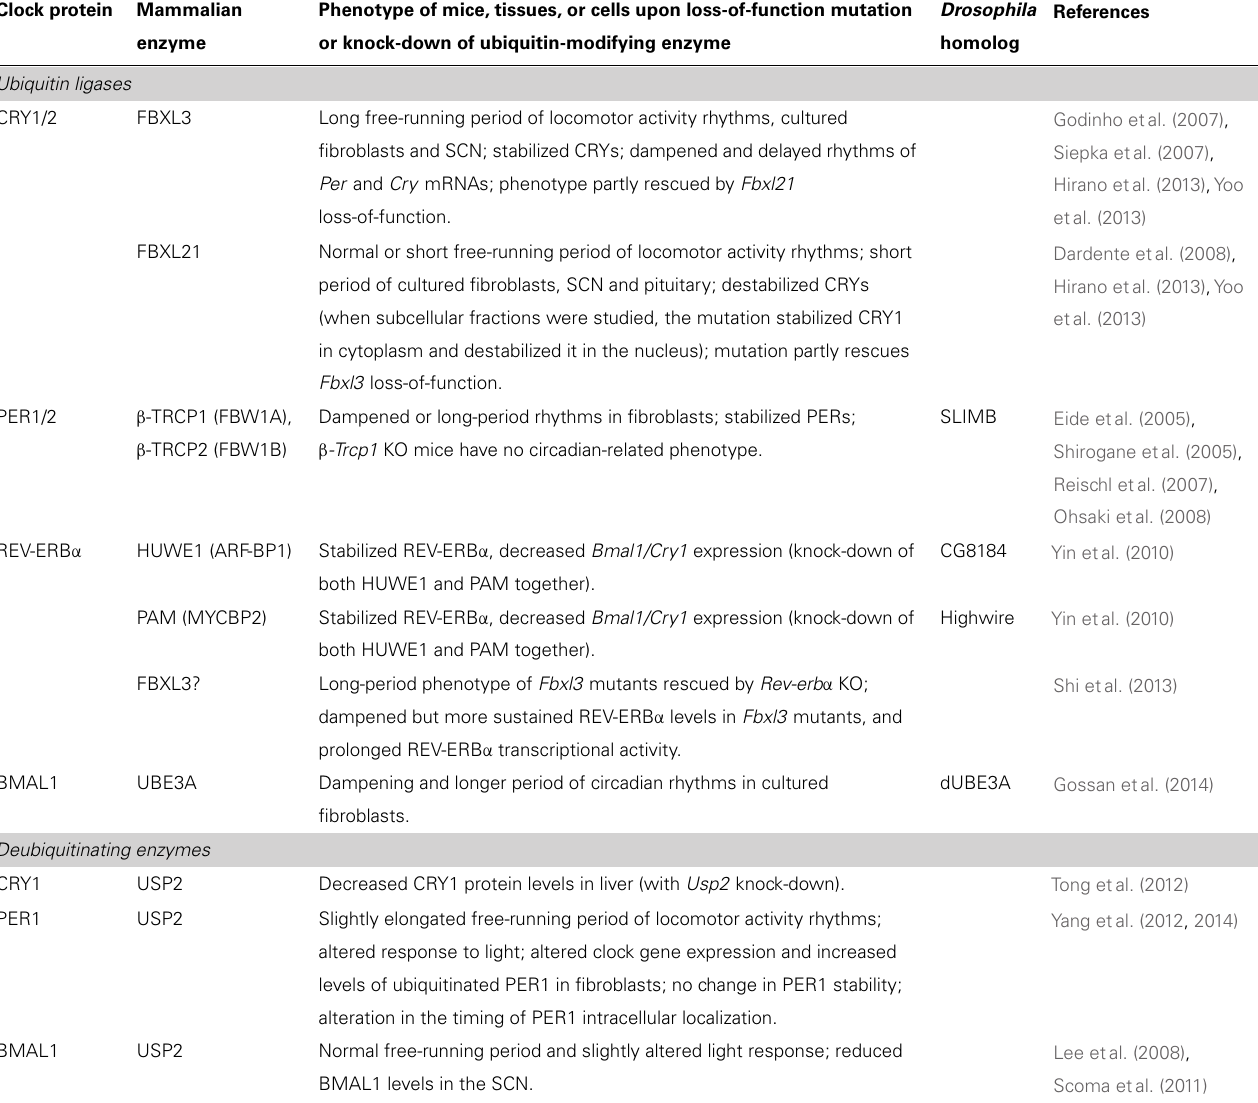
Table 1 | Ubiquitin-modifying enzymes involved in the regulation of mammalian clock proteins. Clock protein